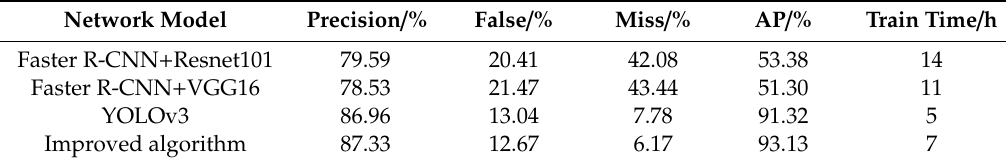
Table 4. Performance comparison of four models on the MyShip